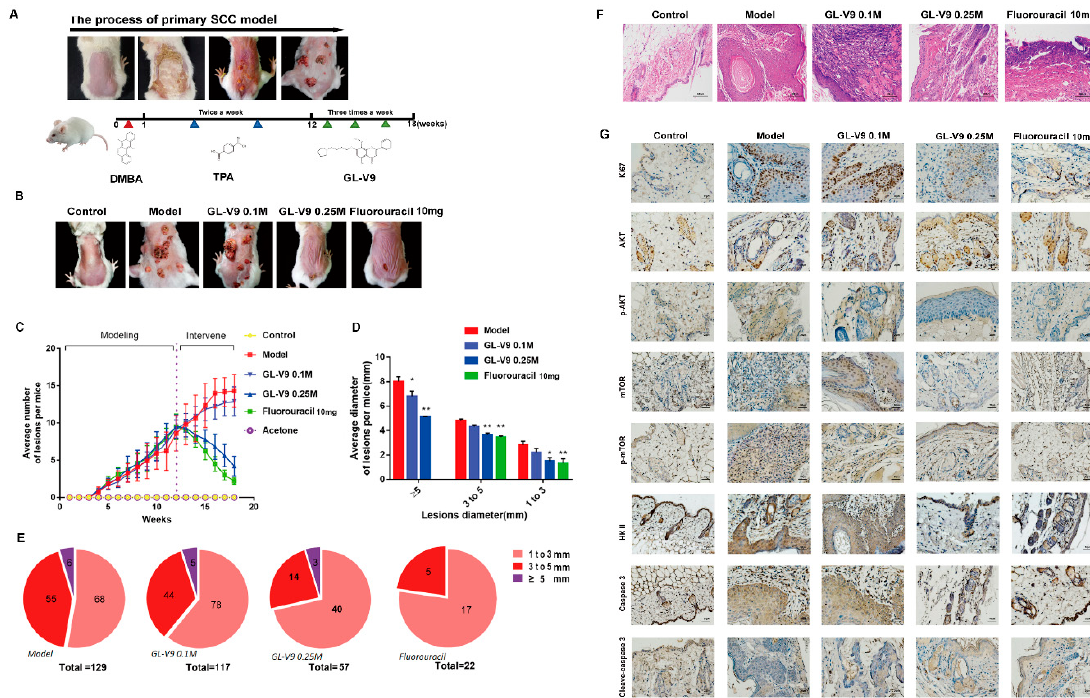
Figure 7. In vivo anticancer effects of GL-V9 on primary skin cancer model. ( A ) Tumor development in DMBA/TPA-induced skin cancer model mice. ( B ) After tumor formation on week 12, mice were applied topically with GL-V9 or 5-Fu to single lesions three times a week. Representative images of papilloma lesion genesis in the indicated groups at week 18. ( C ) The number changes of tumors during the whole process ( n = 10 per group). Bars, SD. ( D ) Average diameter of lesions per mice ( n = 10 per group). Bars, SD. * p < 0.05 and ** p < 0.01 (comparison to the model group). ( E ) Proportion of lesions with different diameters ( n = 10 per group). ( F ) Images of H&E staining of lesion. Scale bar = 100 μ m. ( G ) Proteins expressions in lesion were assessed by immunohistochemistry. Scale bar = 20 μ m .